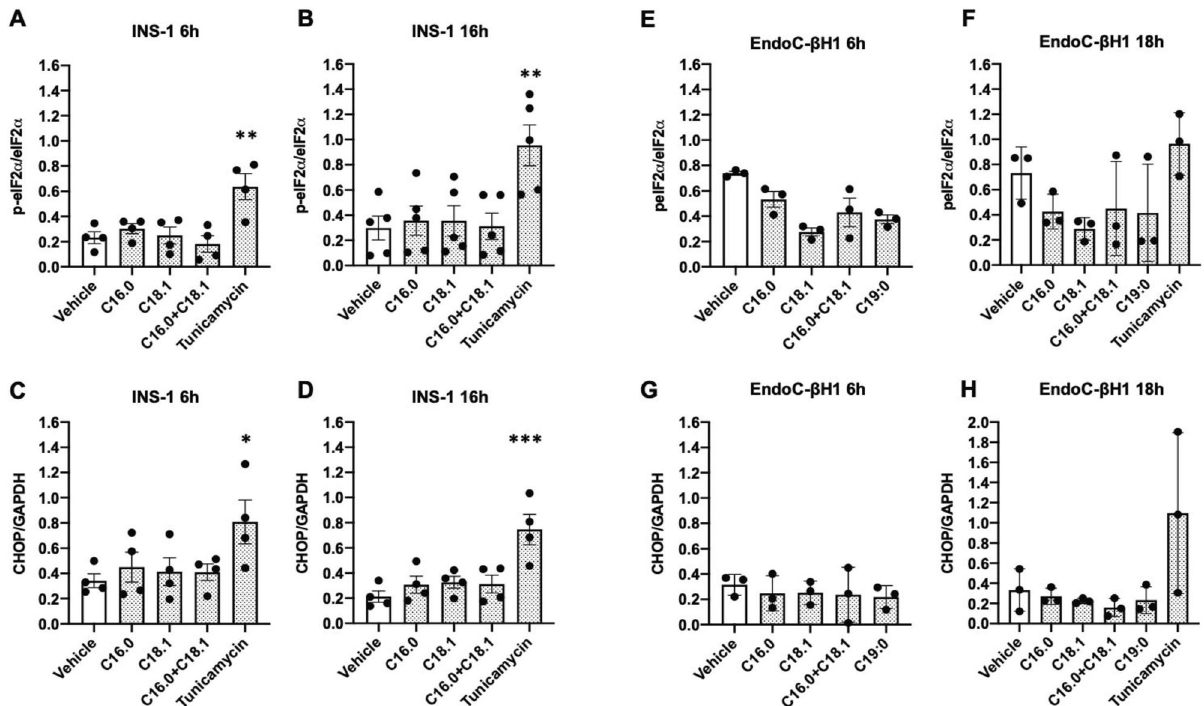
Fig. 5 LC-FFA do not activate ER stress in rodent or human β -cells. INS-1E ( A – D ) and EndoC- β H1 cells ( E – H ) were treated with either 250 μ M C16:0, 250 μ M C18:1, 250 μ M C19:0, 250 μ M C16:0 + 250 μ M C18:1, or 5 μ g/ml Tunicamycin for 6 h,16 h or 18 h. Total eIF2a, peIF2a, CHOP and GAPDH levels were analysed by Western blotting and quanti fi ed as peIF2 α /total eIF2 α ratio or CHOP/GAPDH ratio. Dots represent individual data points. Data are mean + SD ( N = ≥ 3). * P < 0.05, ** P < 0.01, *** p < 0.005 relative to